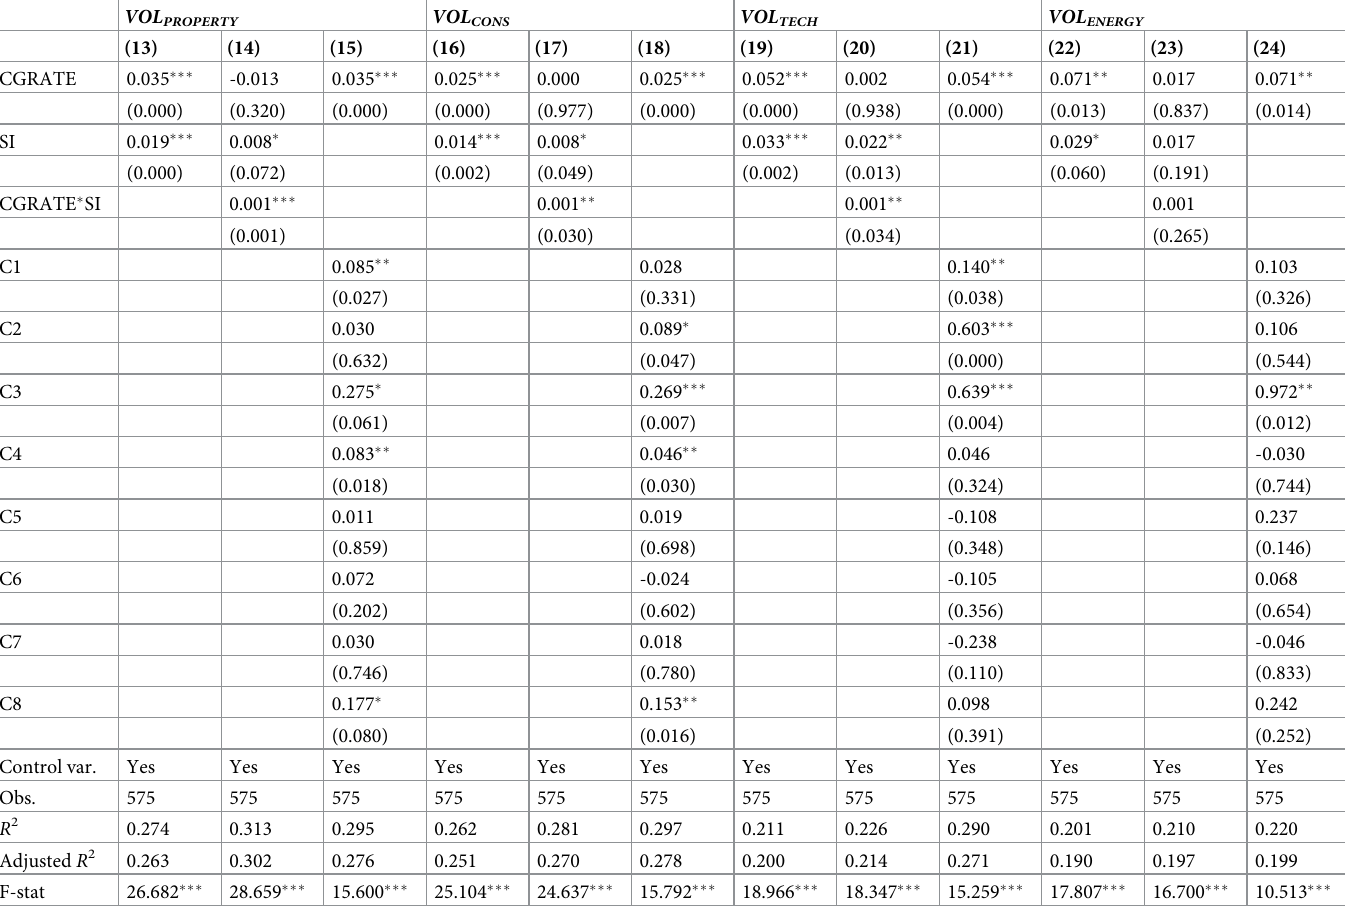
Table 8. Robustness tests: Alternative dependent variables using different sector indices